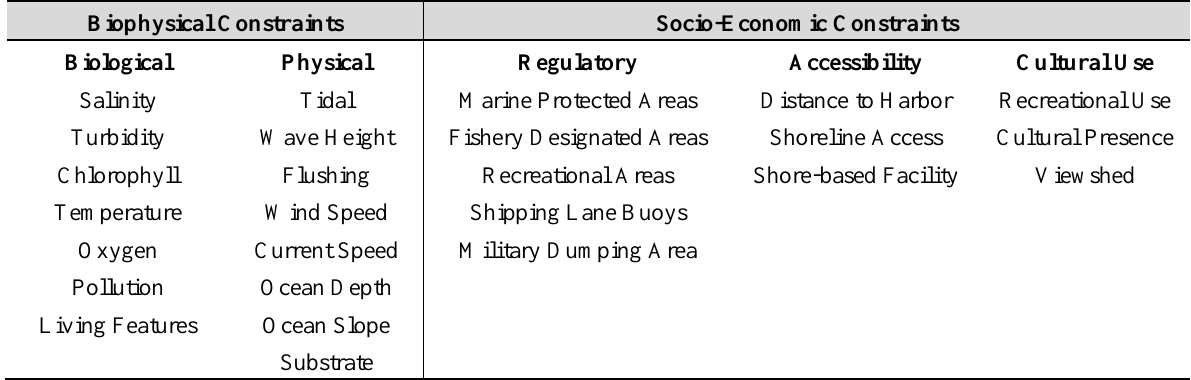
Table 2. Biophysical and socio-economic constraints to aquaculture development.